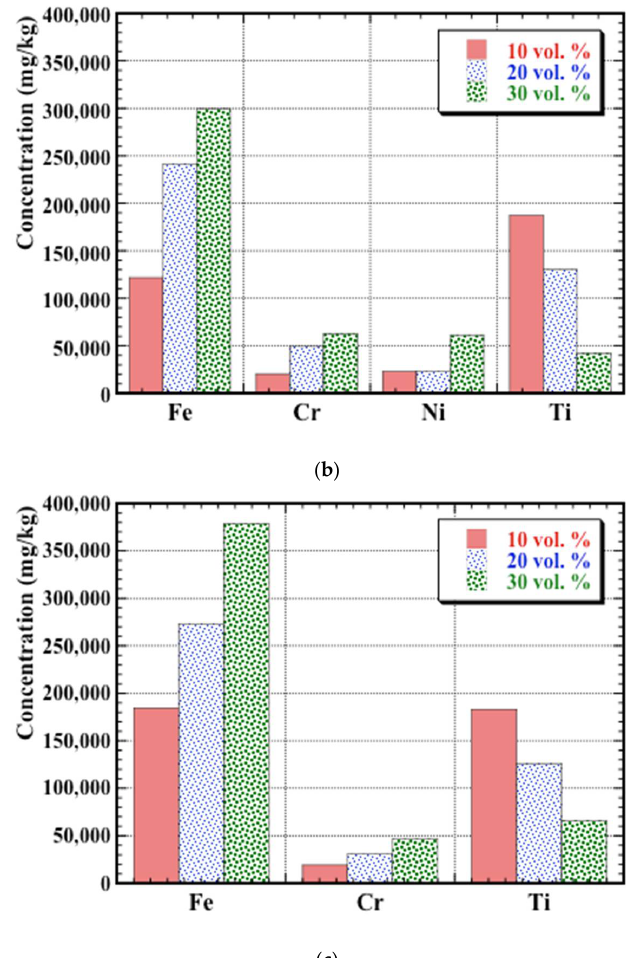
Figure 9. Inductively coupled plasma optical emission spectroscopy (ICP-OES) analyses of the filtered material removed from the post-test solutions after corrosion testing of the TiC–stainless steel cermets: ( a ) TiC-304 L; ( b ) TiC-316 L; and ( c ) TiC-410 L.